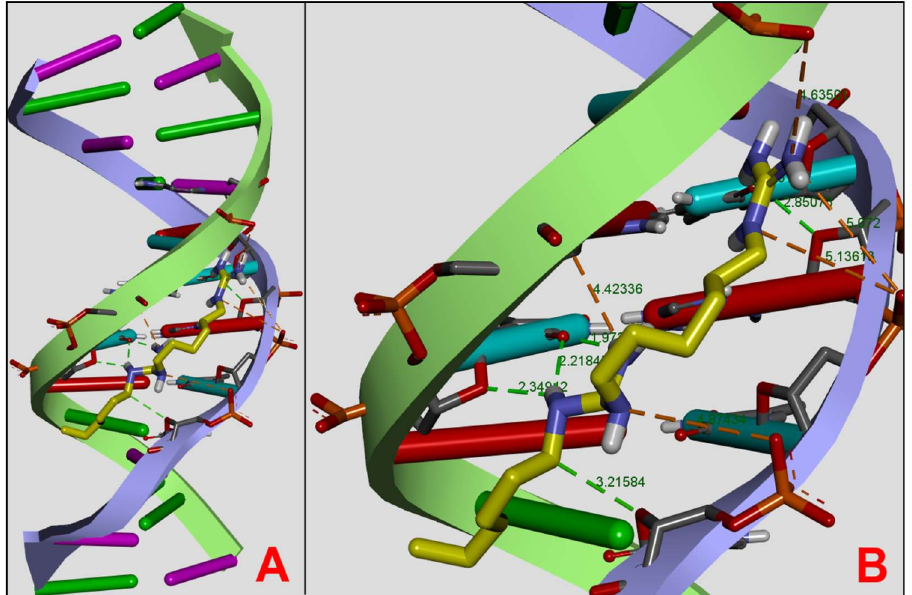
Figure 11. PHMG can dock to DNA in the minor groove and is stabilized by hydrogen and electro- static bonds. Shown here are two views of a DNA–PHMG dimer complex produced by molecular docking studies using the model DNA oligonucleotide 1DNE. ( A ) A general view of the PHMG dimer (yellow) docking in the minor groove of DNA. ( B ) Detailed docking position including the hydrogen (green) and electrostatic (orange) bonds with bond lengths (